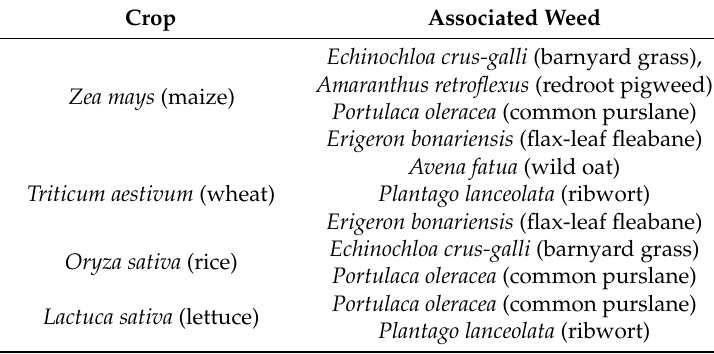
Table 3. Crops and associated weeds tested in this work.